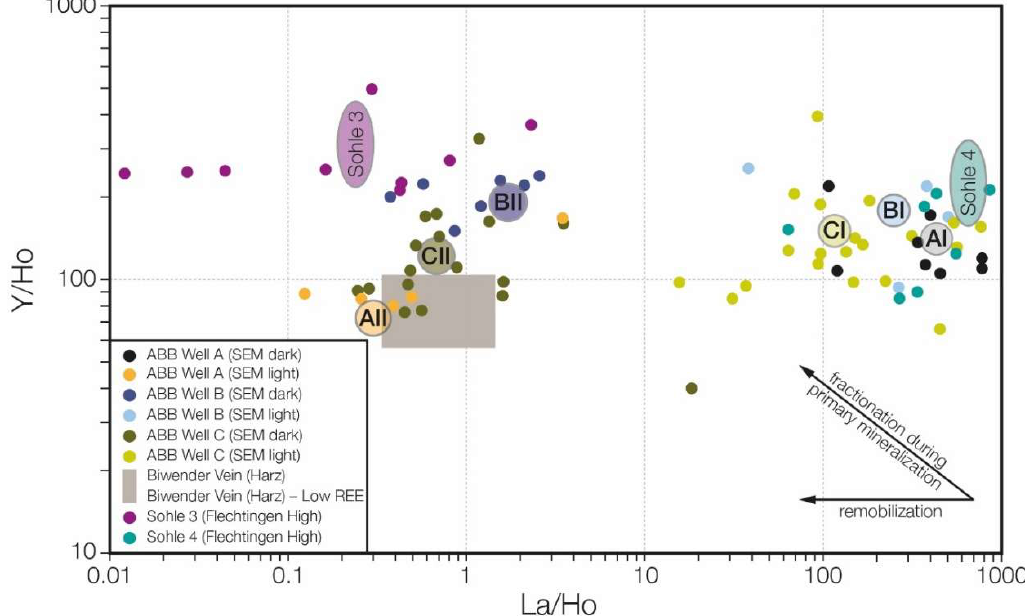
Figure 9. Tb/La versus Tb/Ca atomic ratio diagram after Möller et al. [33] for fluorite from the ABB, LSB, Biwender Vein (Harz), and Flechtingen High. For reference, fields compiled and established by Makin et al. [28], Duschl et al. [11], and Kraemer et al. [43]—North Pennine Ore Field (NPO), Alston Block (A) and Askrigg Block (B) are plotted. Labels, groupings and colours in the diagram (e.g., AI, Sohle 3) correspond to sample populations shown in Figures 4 and 5. See text for discussion.